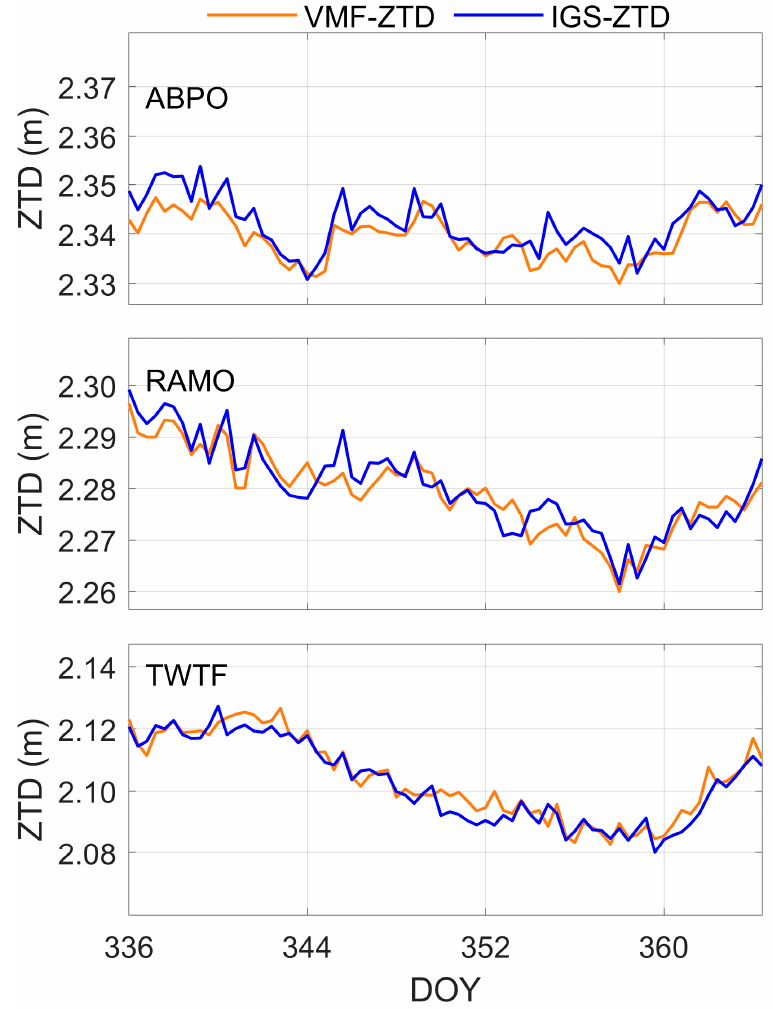
Figure 5. Comparison of the ZTD time-series trends at DOY 336–366, 2020 between IGS-ZTD and VMF-ZTD in collocated stations.